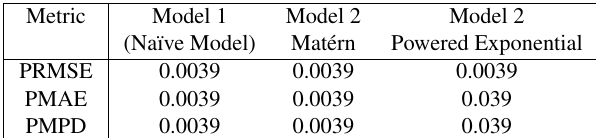
Table 8. Model 4 - p -values for paired Wilcoxon test